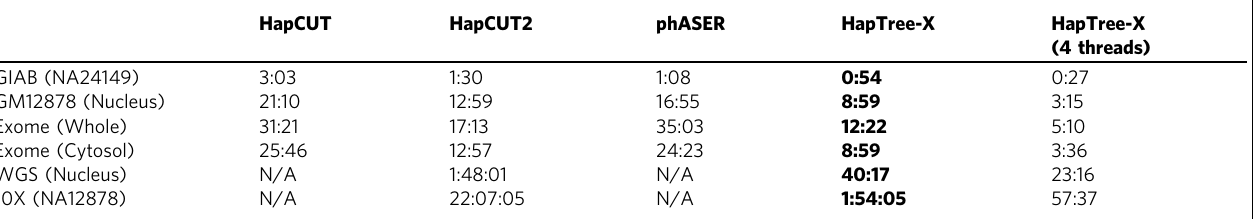
Boldvaluesrepresentthefastestruntimeinsingle-threadedmodeonadataset.HapTree-Xisclearlythefastestphaser,beingupto10×fasterthanthefastestcompetitor.N/Aindicatesthatthetoolwas not evaluated on that